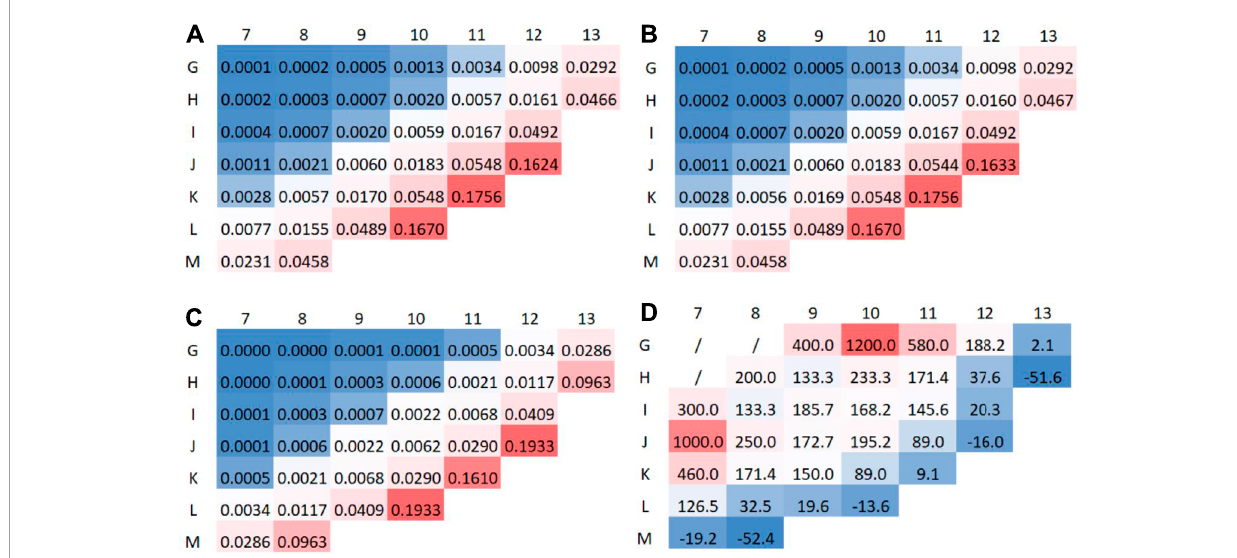
FIGURE 12 Adjoint neutron flux distribution for power range detector response averaged to one core quadrant, calculated with ADVANTG/Denovo per fuel assembly. Values are presented in colours, ranging from high values in red to low values in blue. C denotes ADVANTG calculation and R reference